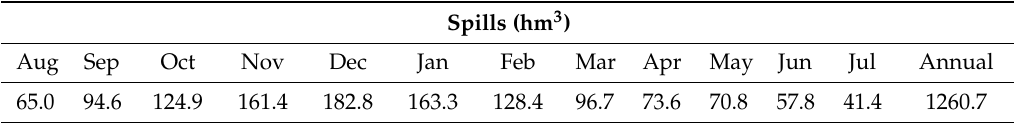
Figure 5. Validation of recorded and modeled volumes discharged by the Potrerillos Dam, 2006 – 2015. Table 3. Averages spills at Potrerillos Dam,